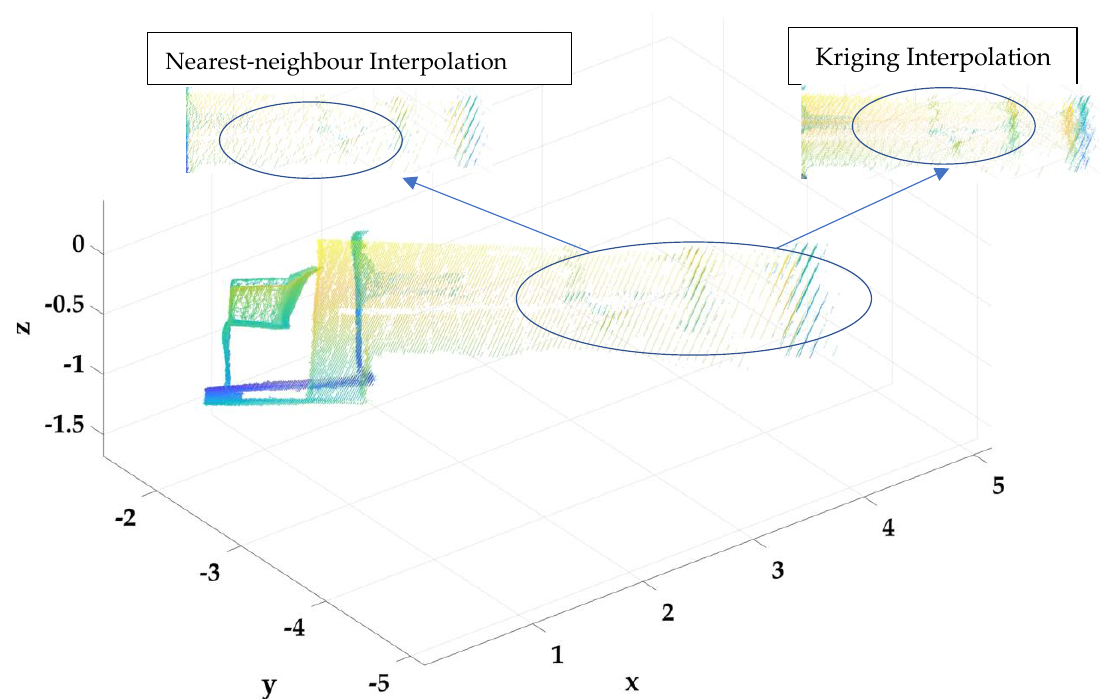
Figure 13. Comparison of details of the Kriging and nearest-neighbour interpolation algorithms.